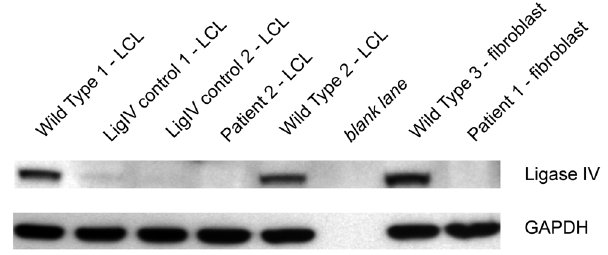
Figure 12. Western blot of whole cell lysates from Patient 1 fibroblasts and Patient 2 lymphblastoid cell lines. Patients 1 and 2 show an absence of ligase IV protein. Lanes were loaded with 50 m g protein/lane. LCL = lymphoblastoid cell line;